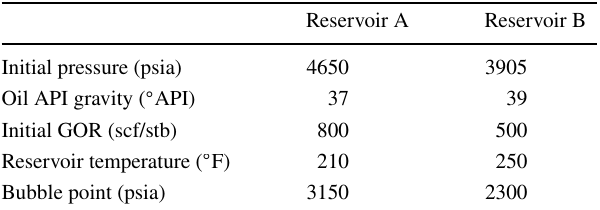
Table 1 Reservoir